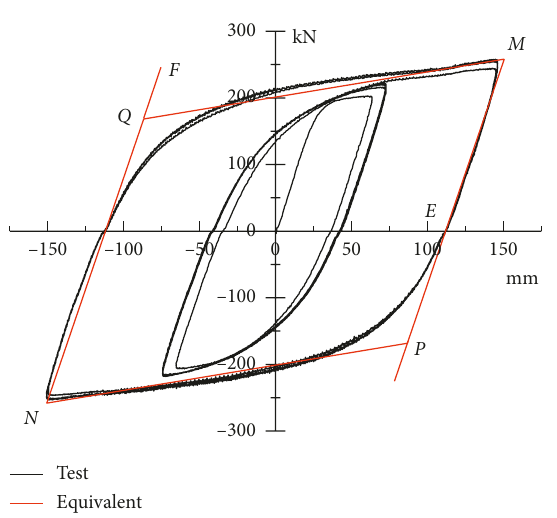
Figure 13: Schematic diagram of equivalent